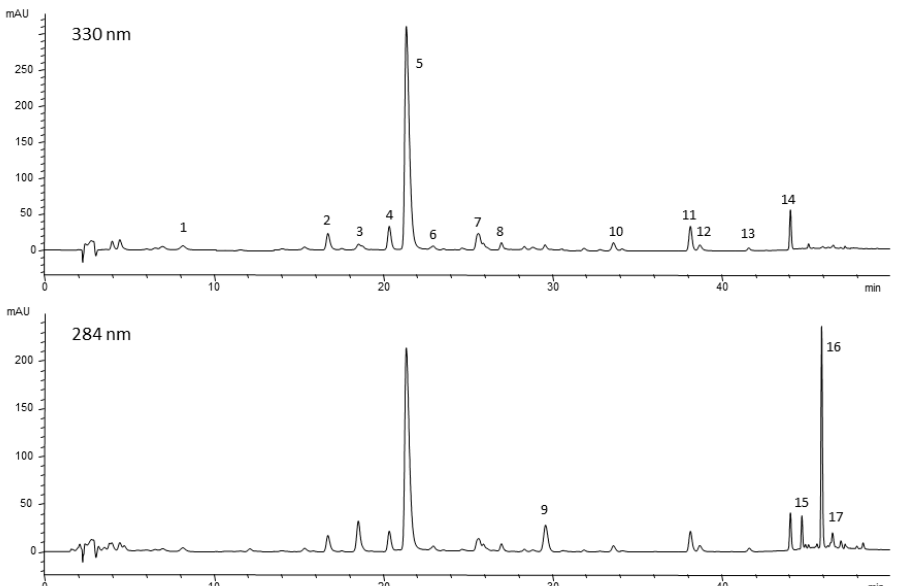
Figure 4. HPLC profiles at 330 and 284 nm of the ethanol extract from fresh young foliar tissue (LY). 1, caffeic acid; 2, isoorientin (luteolin 6- C -glucoside); 3, hesperidin; 4, homoplantaginin (hispidulin 7- O -glucoside); 5, rosmarinic acid; 6, luteolin 7- O -glucuronide; 7, isoscutellarein 7-O-glucoside; 8, flavonoid 1; 9, rosmanol derivative; 10, dihydroxy-dimethoxyflavone; 11, cirsimaritin; 12, flavonoid 2; 13, genkwanin; 14, 4 ′ -methoxytectochrysin; 15, carnosol; 16, carnosic acid; 17, me- thyl carnosic acid.